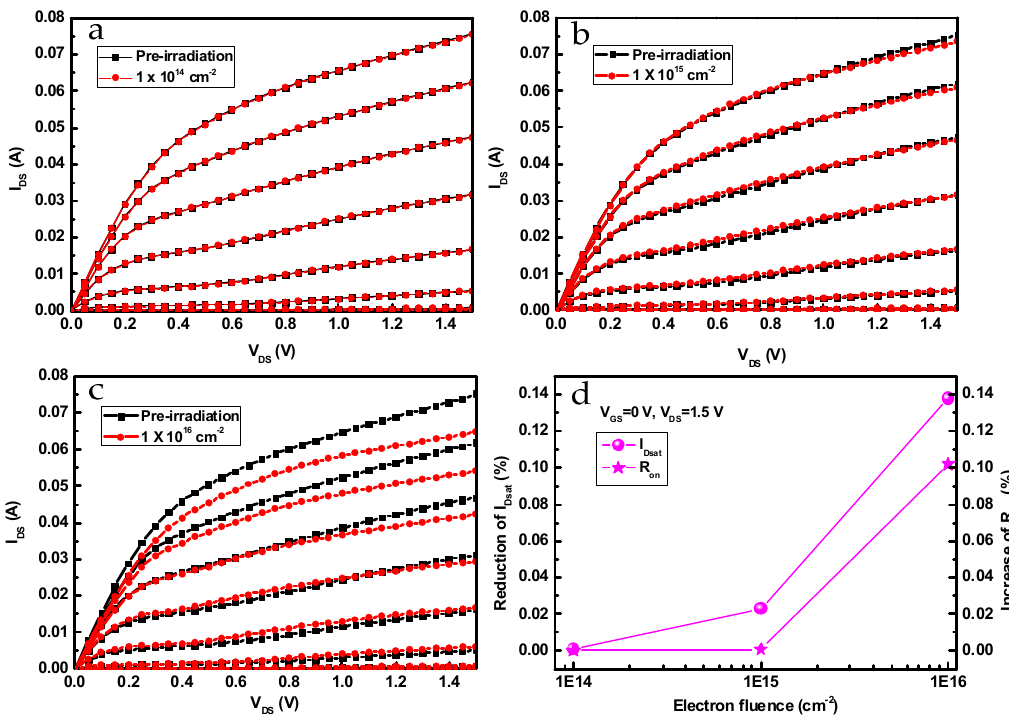
Figure 2. Output characteristics of InP-based HEMTs before and after 1 MeV electron irradiation with different irradiation fluences. ( a ) 1 × 10 14 cm − 2 , ( b ) 1 × 10 15 cm − 2 , ( c ) 1 × 10 16 cm − 2 , ( d ) I D,sat and R on at V GS = 0 V.